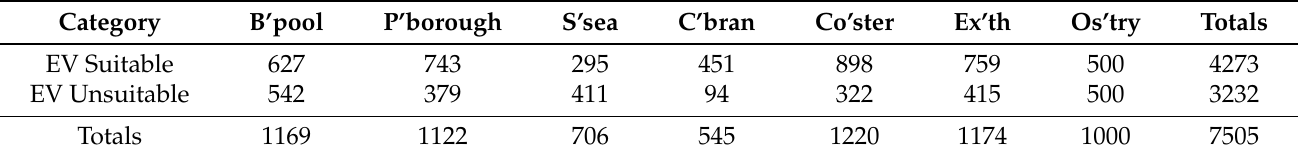
Table 3. A breakdown of the image dataset used to retrain CNN 2. The Oswestry data are used for validation and hyper-parameter